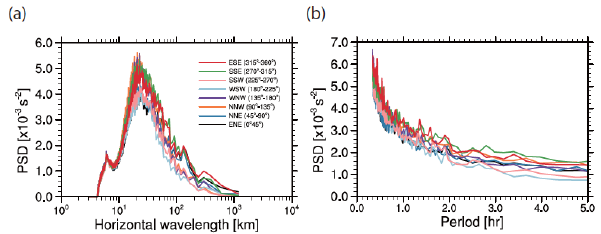
Fig. 3. PSDs of the HDTGW with respect to the (a) horizontal wavelength and (b) period in each propagation direction with 45 ◦ intervals at